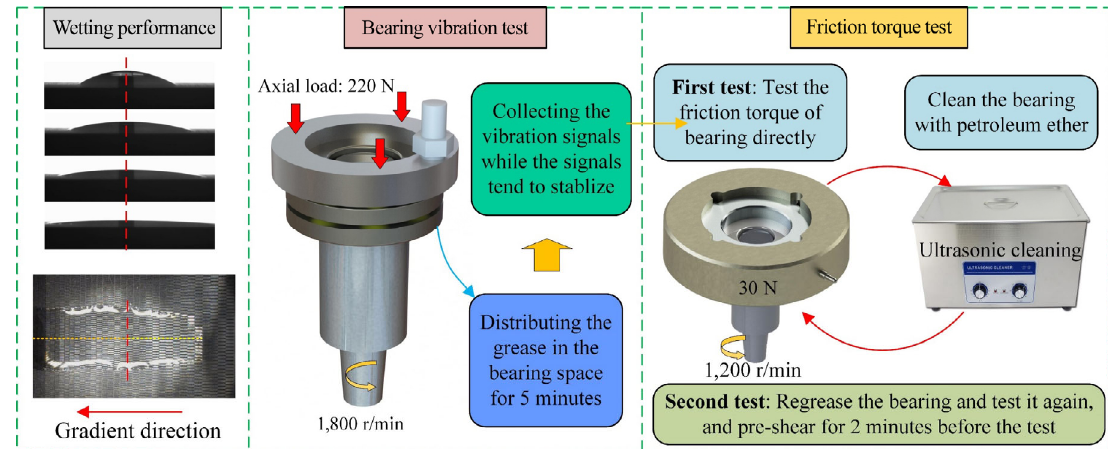
Fig. 6 Overview of experimental